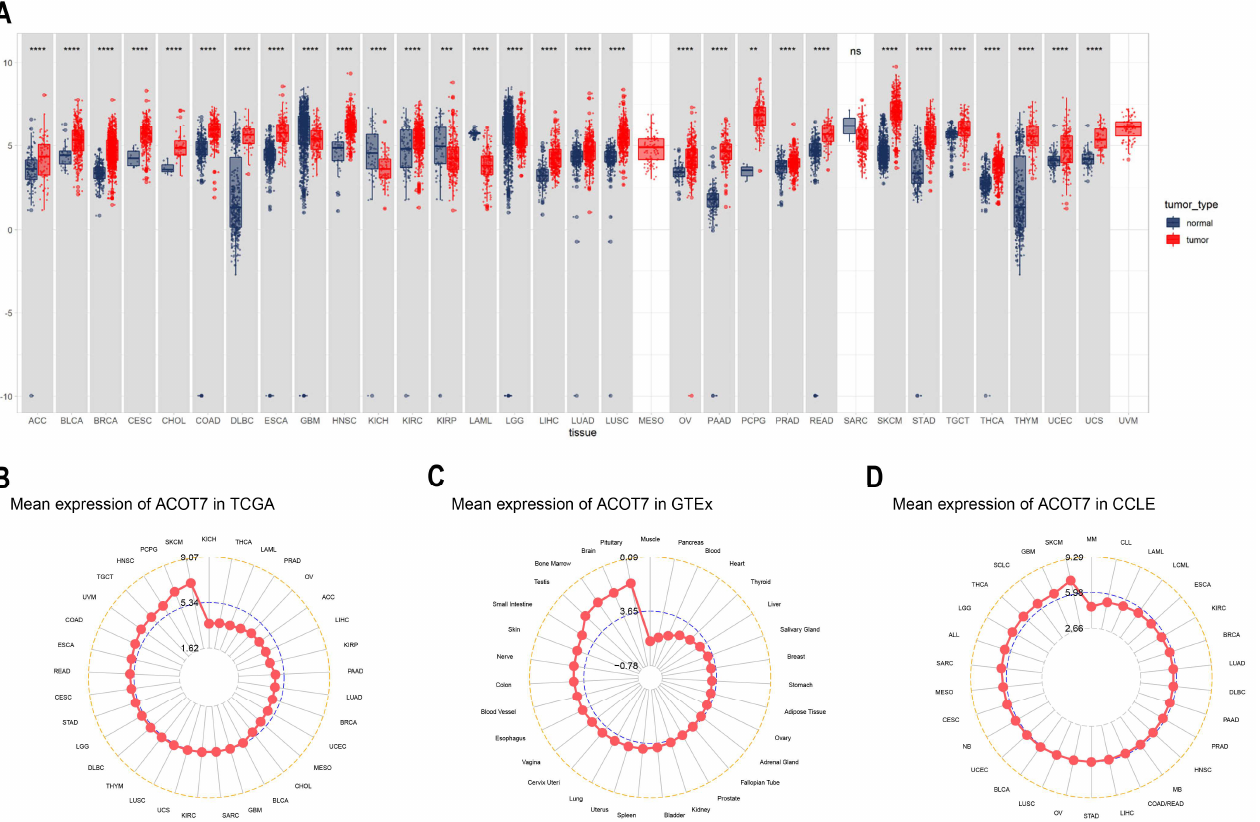
Figure 1. Differential expression of ACOT7 in human cancers. ( A ) Comparison of ACOT7 expression between tumors and normal samples from TCGA and GTEx datasets. ( B ) ACOT7 expression in 33 cancers from TCGA dataset. ( C ) ACOT7 expression in normal tissues from GTEx dataset. ( D ) ACOT7 expression in tumor cells from CCLE dataset. ** p < 0.01, *** p < 0.001, **** p < 0.0001, ns: not significant.